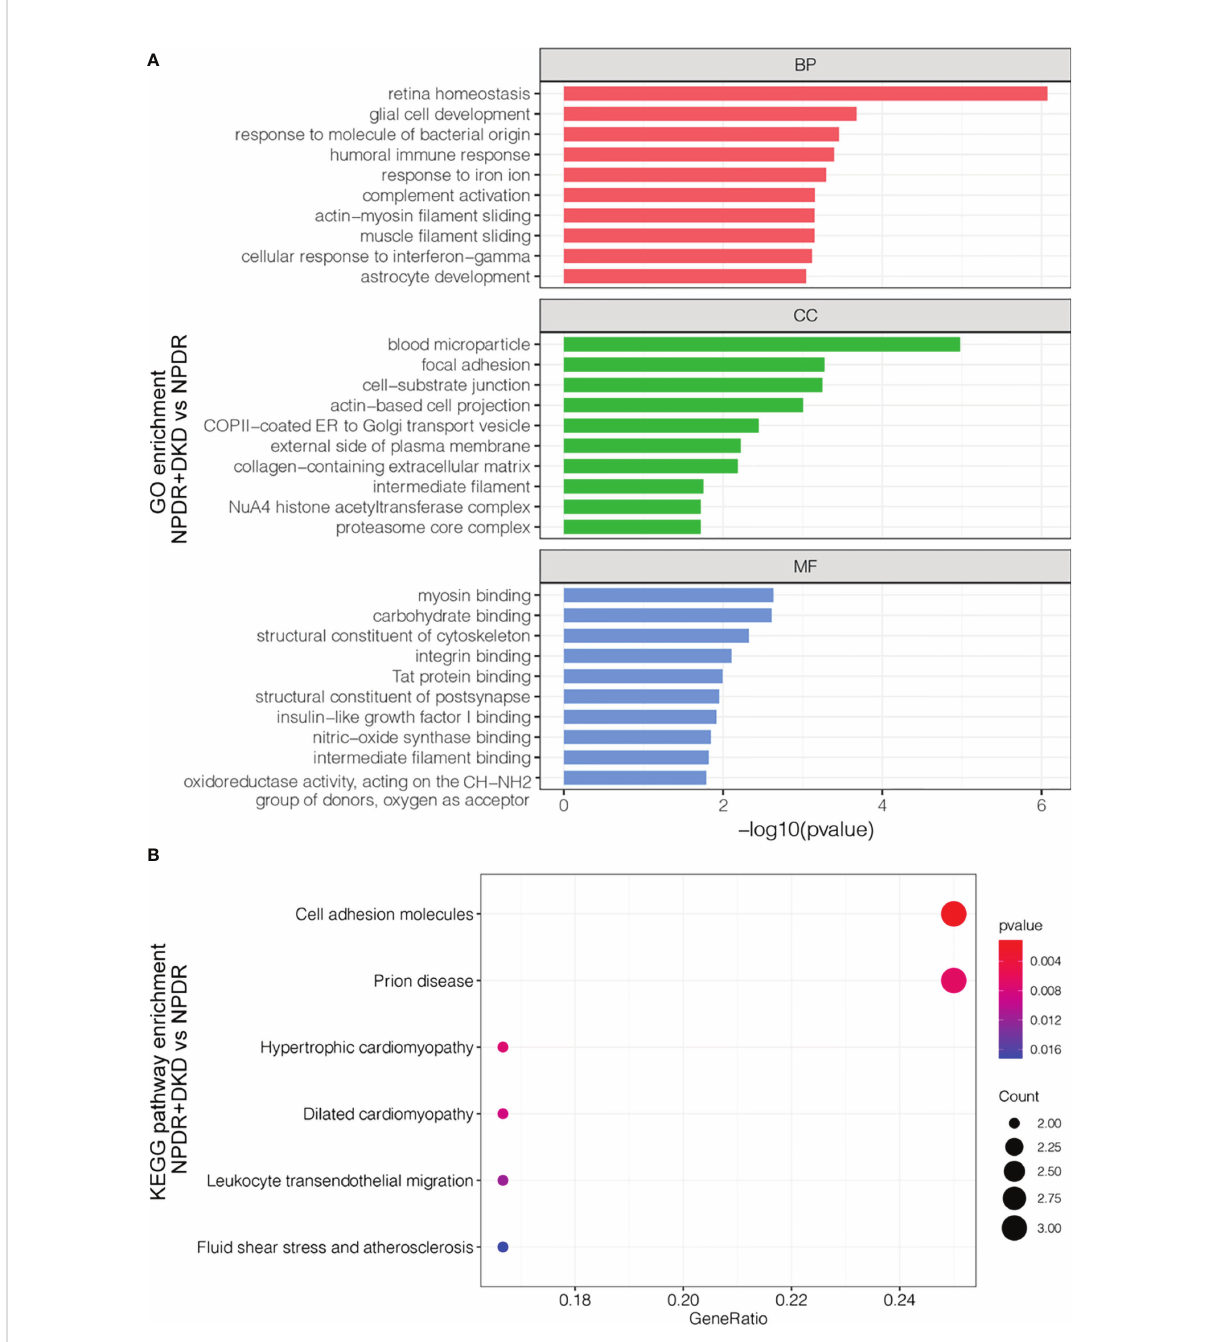
FIGURE 3 Functional analysis of the DEPs. (A) GO analysis of up- and downregulated proteins between NPDR+DKD and NPDR. Only the top 10 terms with the highest -log10(p value) are displayed. BP, biological process; CC, cellular component; MF, molecular function. (B) KEGG pathway enrichment. The larger red dot indicates a lower p value and more enriched proteins in that